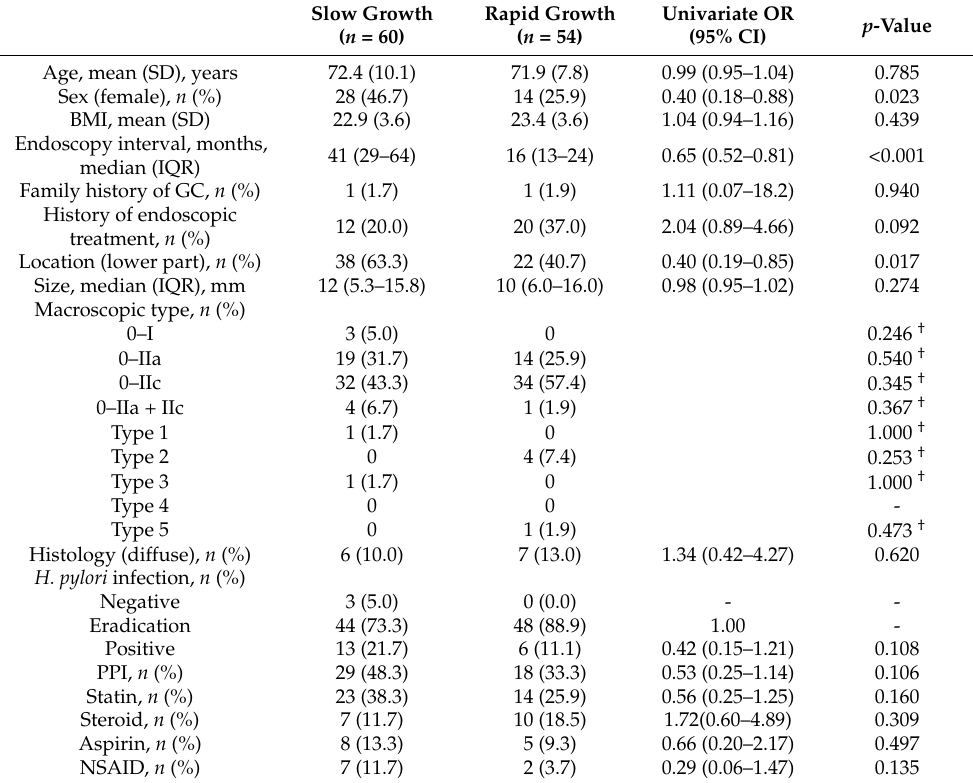
Table 1. Characteristics of patients and lesions.